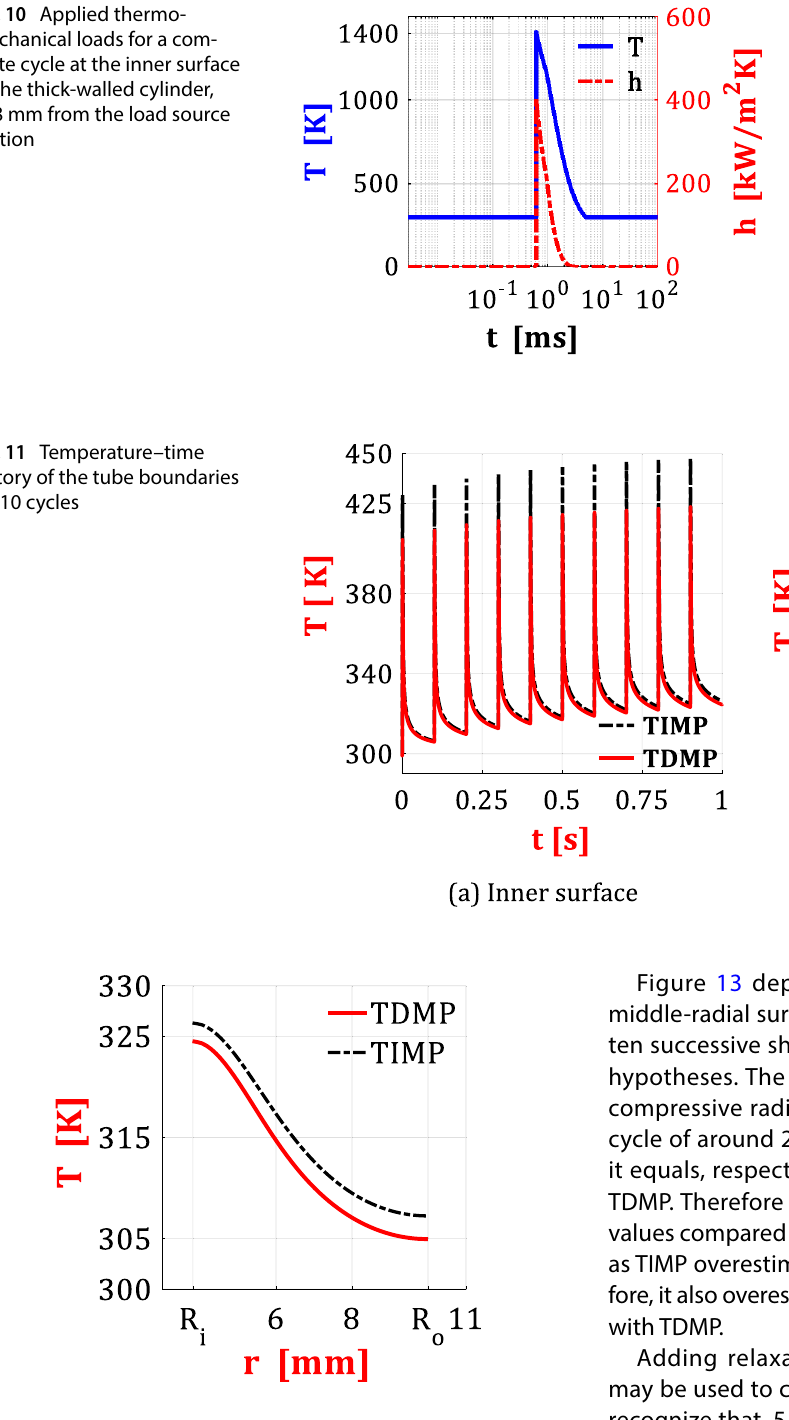
Fig. 12 The temperature variation through the cylinder thickness after the 10